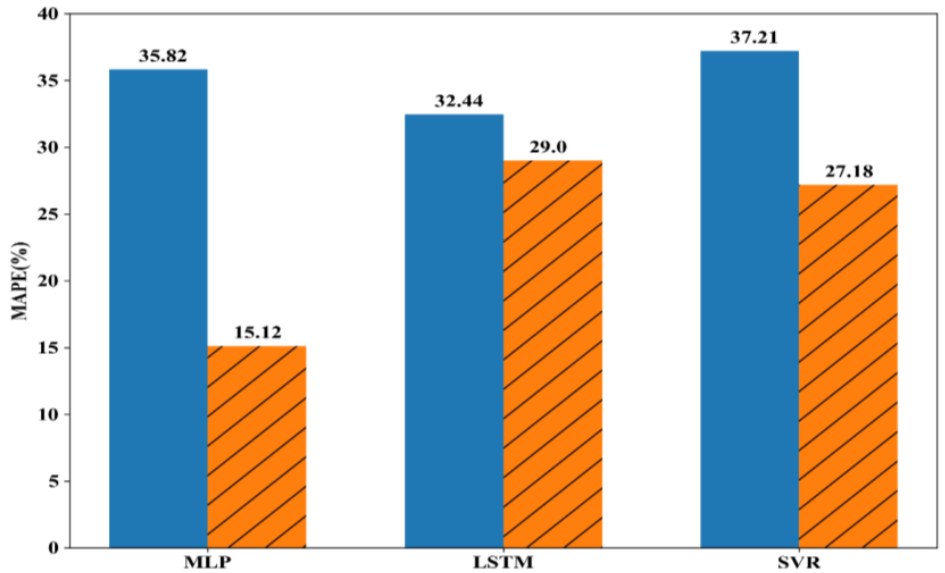
Figure 7. Experiment result for battery #6.